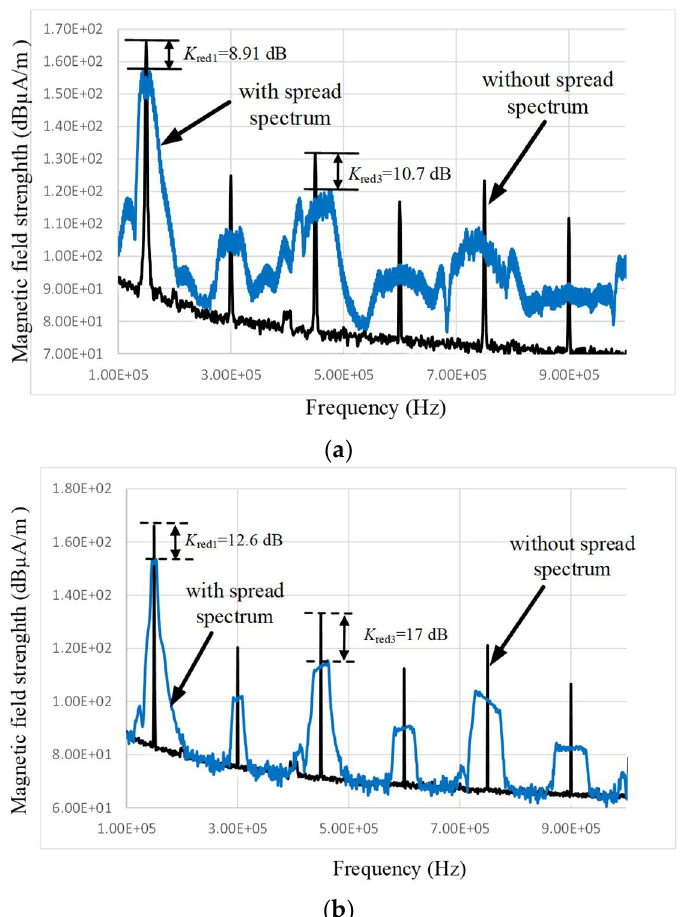
Figure 8. Comparison of spectra of radiated emissions from the WPT system without spread spectrum and with spread spectrum based on ramp SFM: ( a ) f m = 2 kHz, Δ f peak = 12 kHz, RBW = 1 kHz; ( b ) f m = 0.35 kHz, Δ f peak = 5 kHz; RBW = 0.1 kHz).